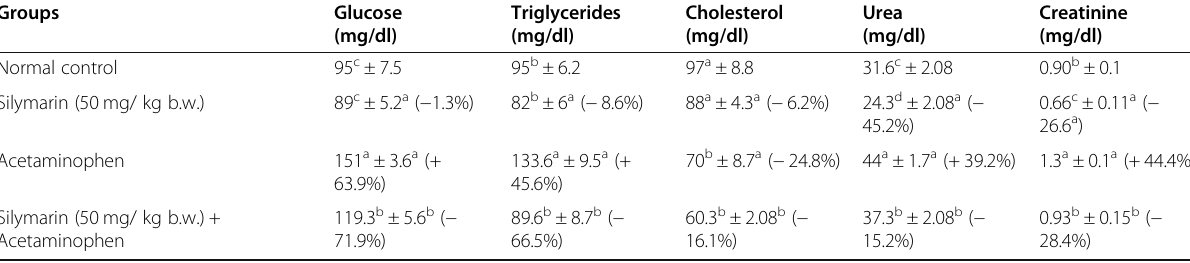
Table 4 Effect of silymarin at dose of 50 mg/kg b.w., on glucose, lipid parameters and kidney function markers in normal and acetaminophen (AAP) dosed rats Groups Normal